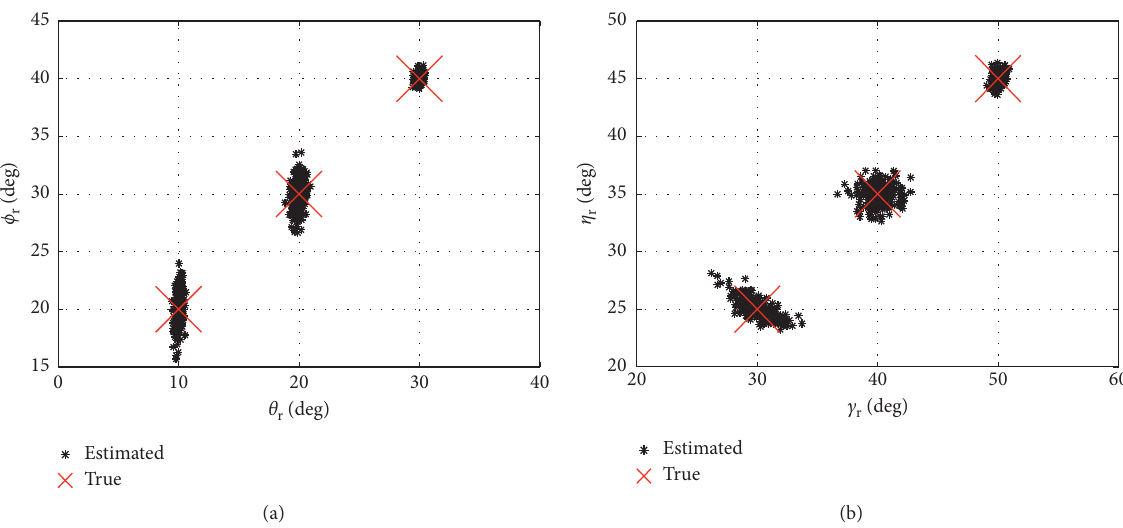
Figure 2: Scattering figures of our algorithm with N � 4, L � 500, and SNR � 20dB: (a) 2D-DOA estimation; (b) polarization parameter estimation.